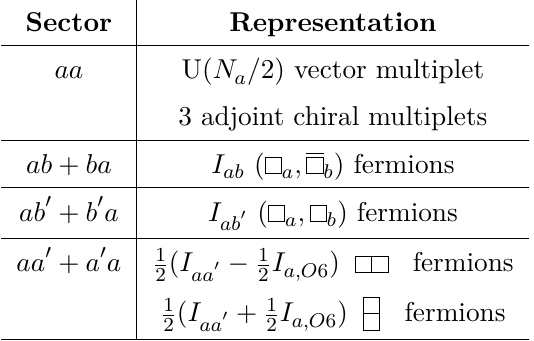
Table 2 . General massless particle spectrum for intersecting D6-branes at generic